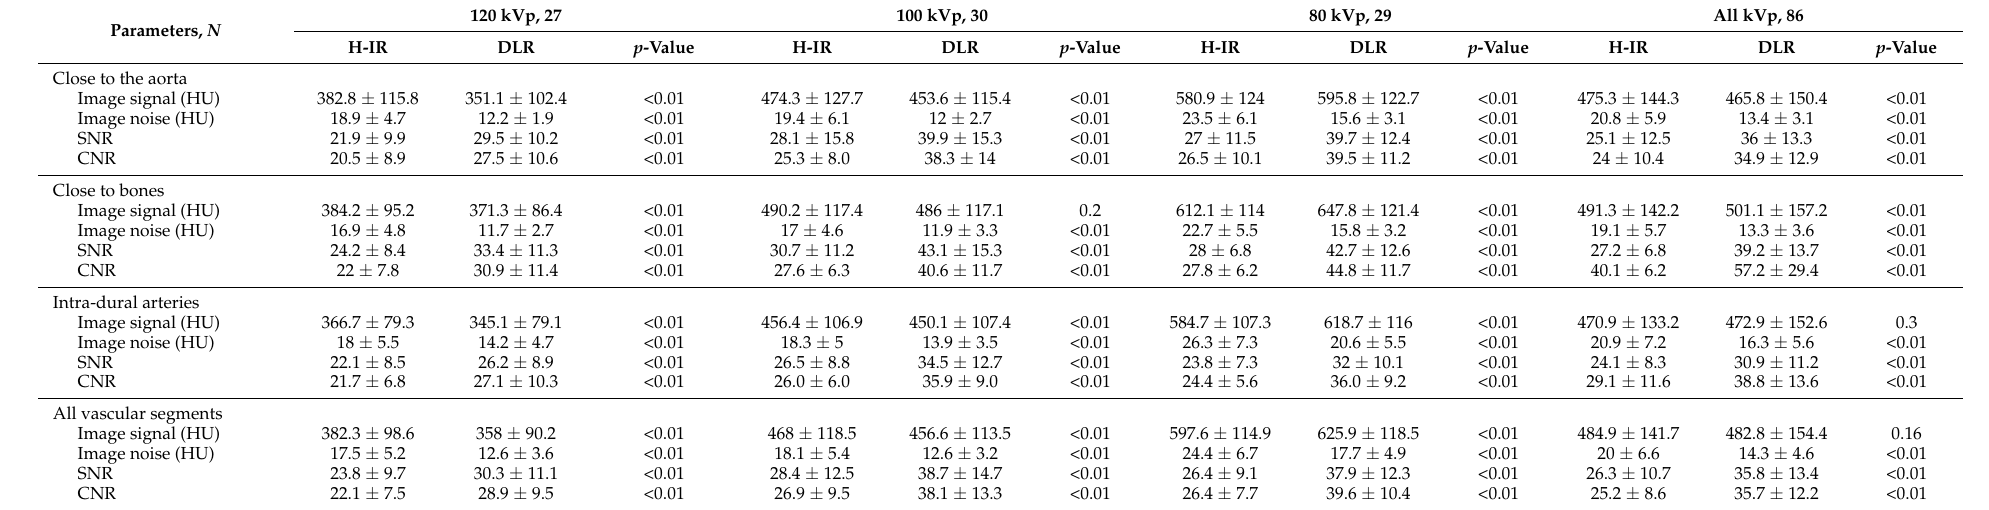
Table 4. Comparison of the two reconstruction techniques at regional levels with constant kVp